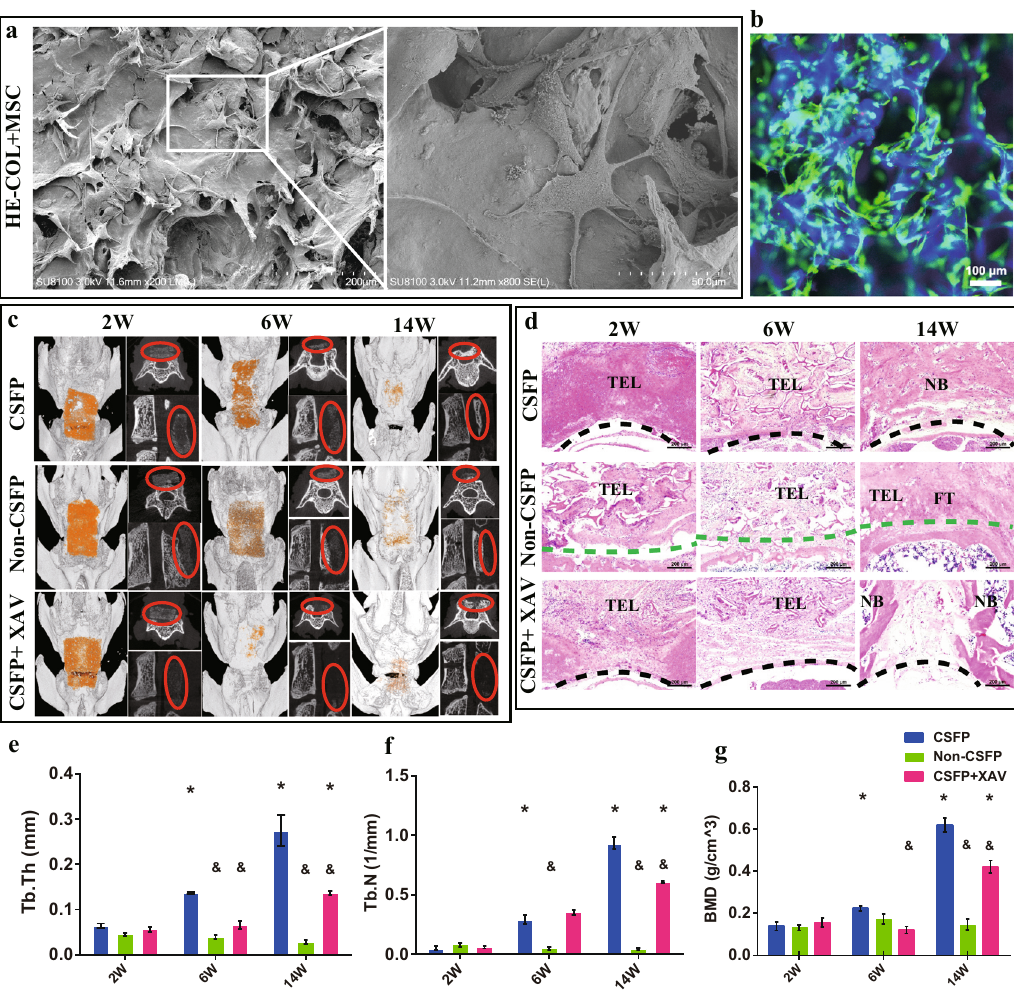
Fig. 4 CSFP promoted the bone formation of tissue-engineered laminae through the regulation of β -Catenin. a SEM images of TEL. b Live/Dead staining of TEL. c Micro-CT scanning and 3-D reconstruction images at the 2nd, 6th, and 14th weeks, the pseudo-orange color shows the TEL, and the red dash circle shows the TEL or newborn bone. d HE staining of TEL at the 2nd, 6th, and 14th weeks. TEL: tissue-engineered laminae, NB: newborn bone, FT: fi brous tissue. e Trabecular thickness (Tb.Th). f Trabecular number (Tb.N). g Bone mineral density (BMD). Data are presented as mean ±SEM. * P < 0.05 (comparison of the same group at different time points), & P <0.05 (comparison of different groups at the same time